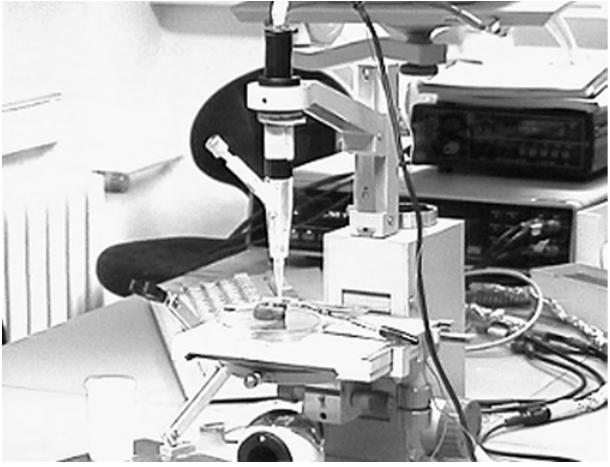
Figure 1. Mini cell system (MCS) used for electrochemical measurements. Figure 2. Current ��. potential polarization curve of AZ31 magnesium alloy in different electrolytes.